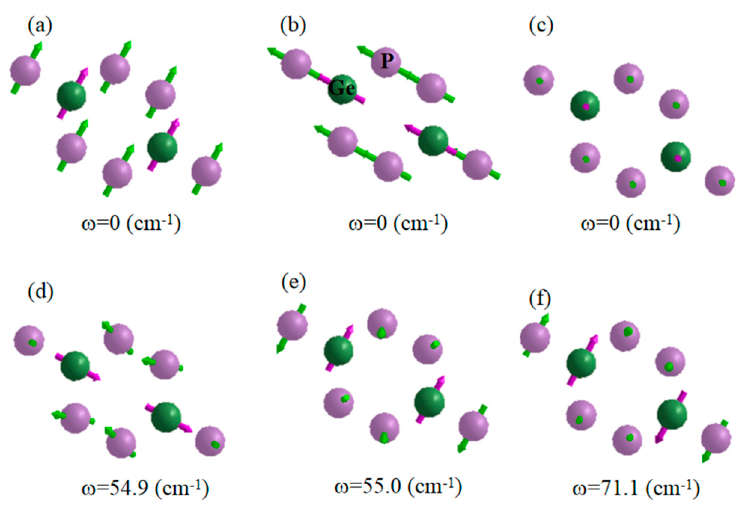
Figure 5. The typical vibrational modes of the acoustic phonon branches (LA ( a ), TA ( b ) and ZA ( c )) as well as three low-frequency optical phonon branches ( d – f ) for monolayer GeP 3 at the Γ point. The arrows denote the atomic displacement directions at 300 K.